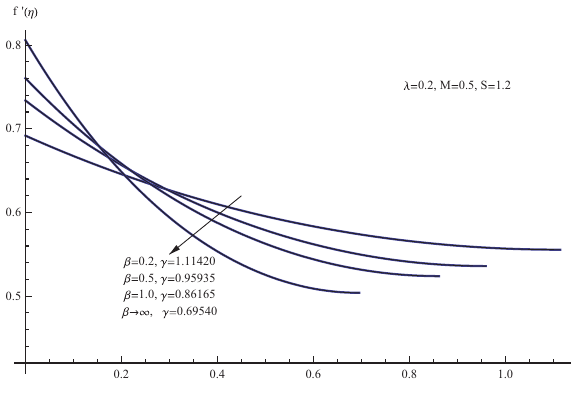
Figure 8: ( ) f η ′ for assorted quantities of β .